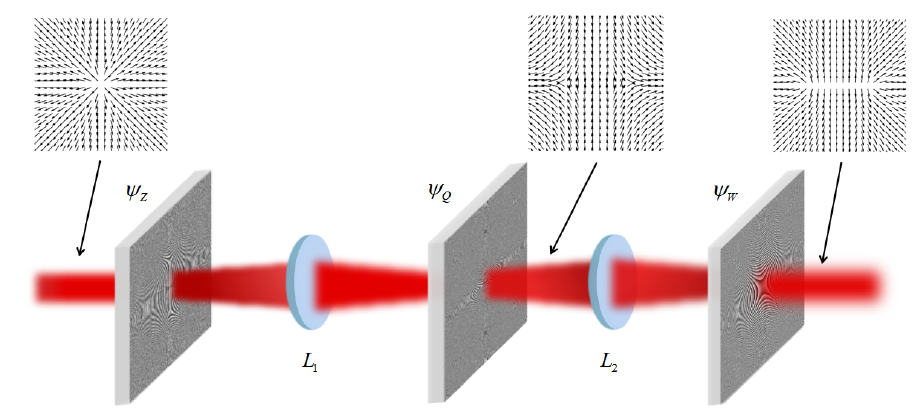
Figure 5. Schematic of 4 f optical system for generating ESRP beam. The three inlets show, respectively, the polarization distribution patterns right before the phase plate ψ Z , and right after the phase plates ψ Q and ψ W